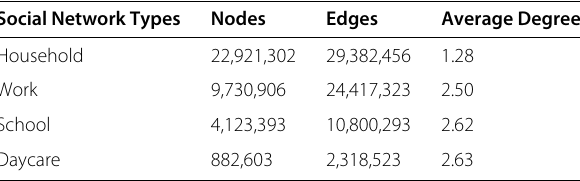
Table 4 Social networks statistics from our synthetic population method Social Network